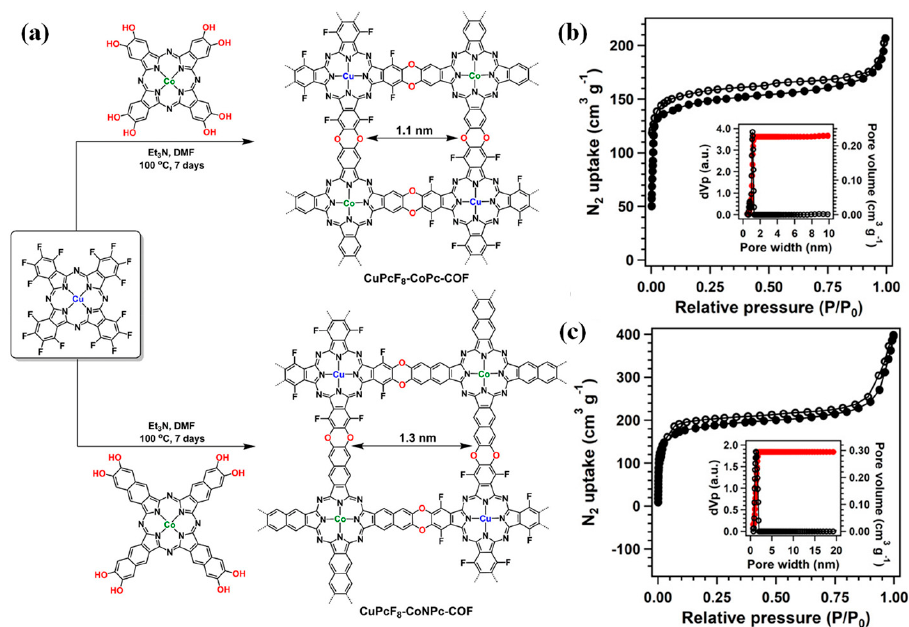
Figure 10. ( a ) Structure of CuPcF 8 − CoNPc − COF and CuPcF 8 − CoPc − COF; N 2 adsorption/desorption isotherms of ( b )CuPcF 8 − CoPc-COF and ( c ) CuPcF 8 − CoNPc − COF [93]. Reprinted with permission from Ref. [93]. Copyright 2021 Copyright American Chemical Society (Washington, DC, USA).